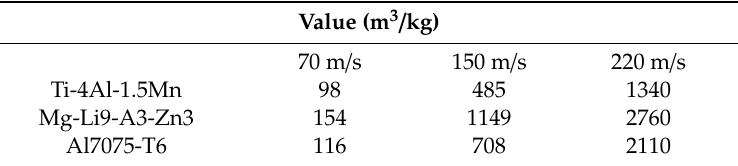
Figure 6. Erosion ratios of three materials at different impact speeds.